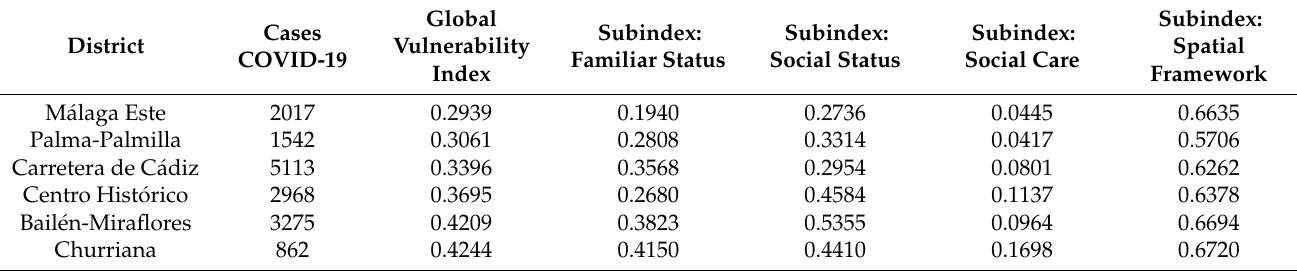
Table 3. COVID contagions and vulnerability indices, global and for the four categories, for every Districts (Sorted ascending by the Global Vulnerability Index). Source: